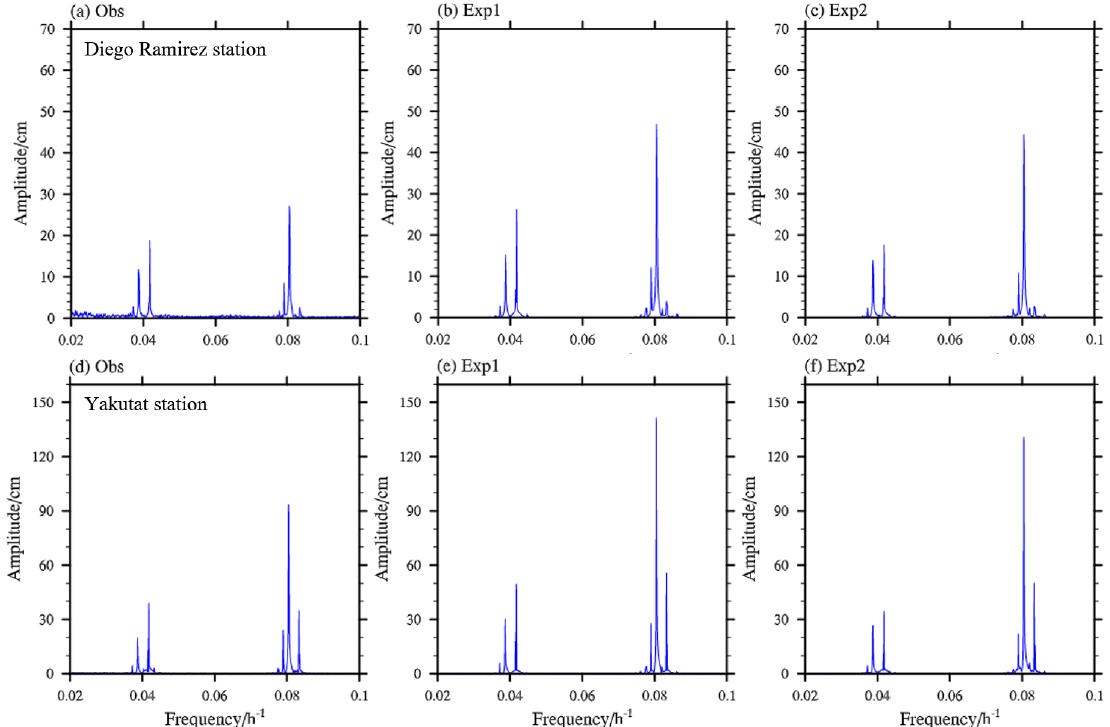
Figure 8. Spectrum analysis of sea surface height for (a, d) the observation (Obs), (b, e) Exp1, and (c, f) Exp2. The observation is from WOCE (Ponchaut et al., 2001). The upper panels are for the Diego Ramirez Islands (56.56 ◦ S, 68.67 ◦ W) and the lower panels are for Yakutat (59.54 ◦ N, 139.73 ◦ W).